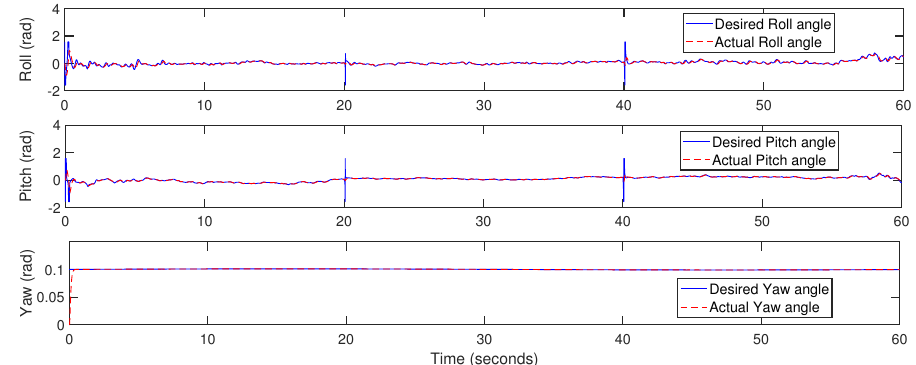
Figure 20. Attitude tracking with Von Karman wind turbulence model. Figures 21 and 22 show the observer’s performance during estimation of disturbance. These results validate the designed nonlinear observer’s performance.